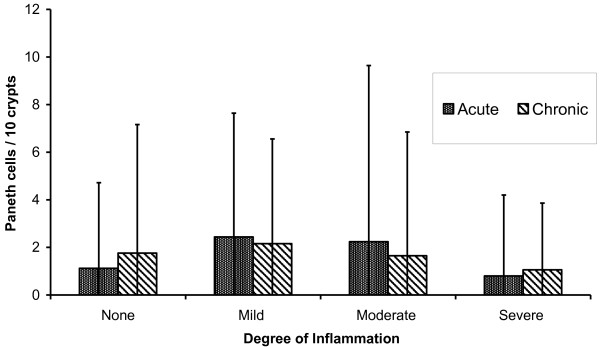
Numbers of Paneth cells (mean and 95% confidence interval) in the distal colon in IBD in relation to local inflammation.